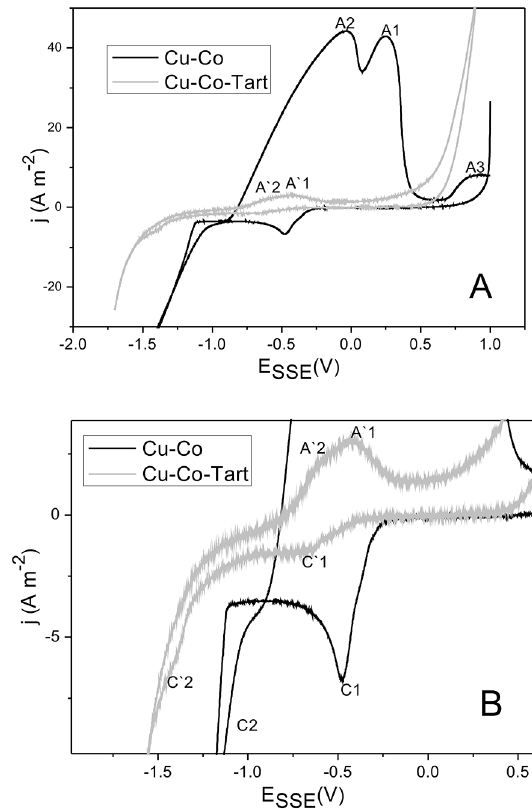
Figure 2. (A) Cyclic voltammograms of graphite electrode in Solutions 1 and 2; (B) Magnification of